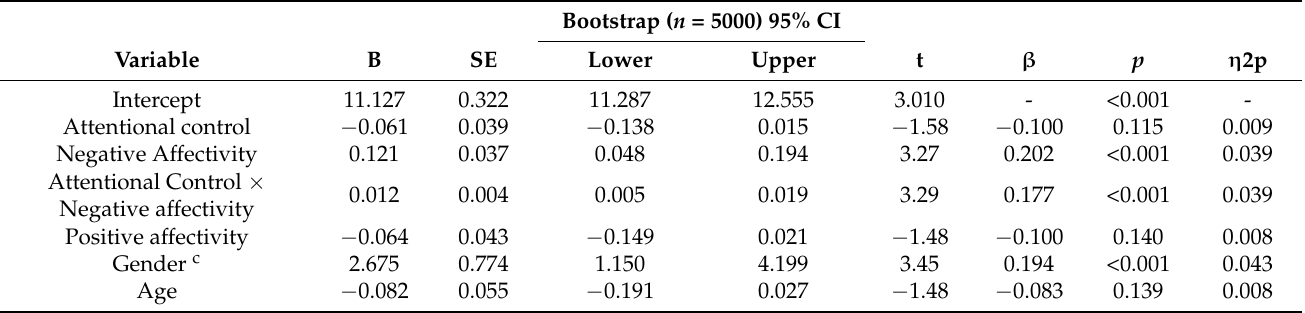
Table 2. Results of moderation analysis.